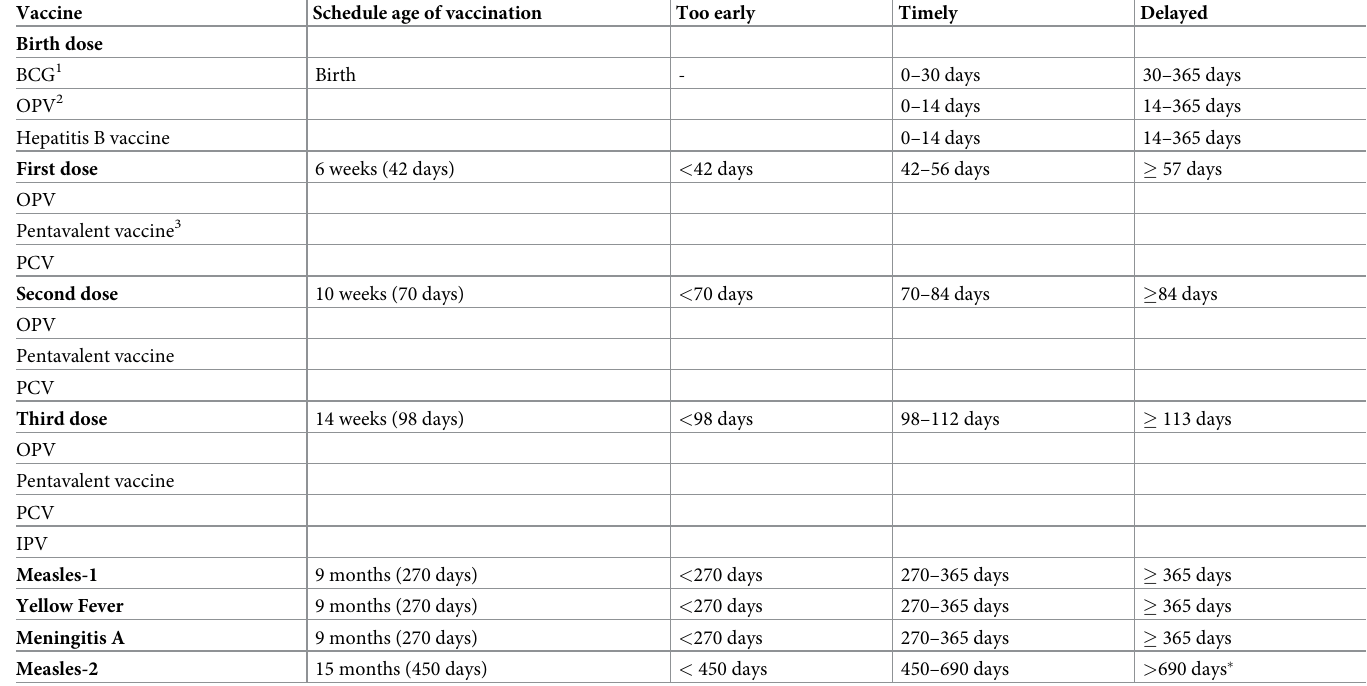
Table 2. Classification of timeliness of vaccinations received by children aged 0–23 months surveyed during a Missed Opportunities for Vaccination (MOV) assess- ment by time intervals, using the national schedule on immunization, Ondo State, Nigeria,